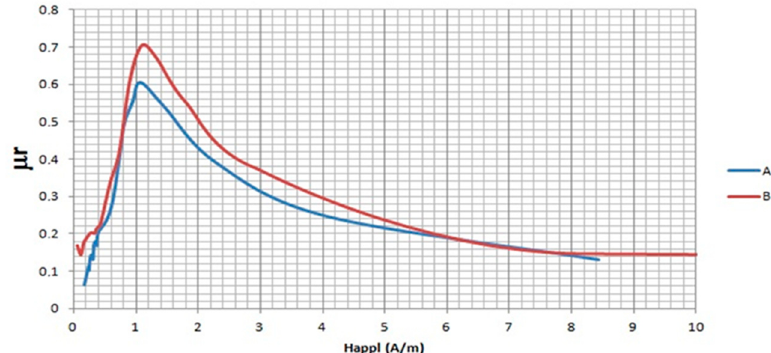
Figure 4. Relative permeability µ r = J/H 0 vs. the applied external field, H appl , for the two nanocrystalline samples.